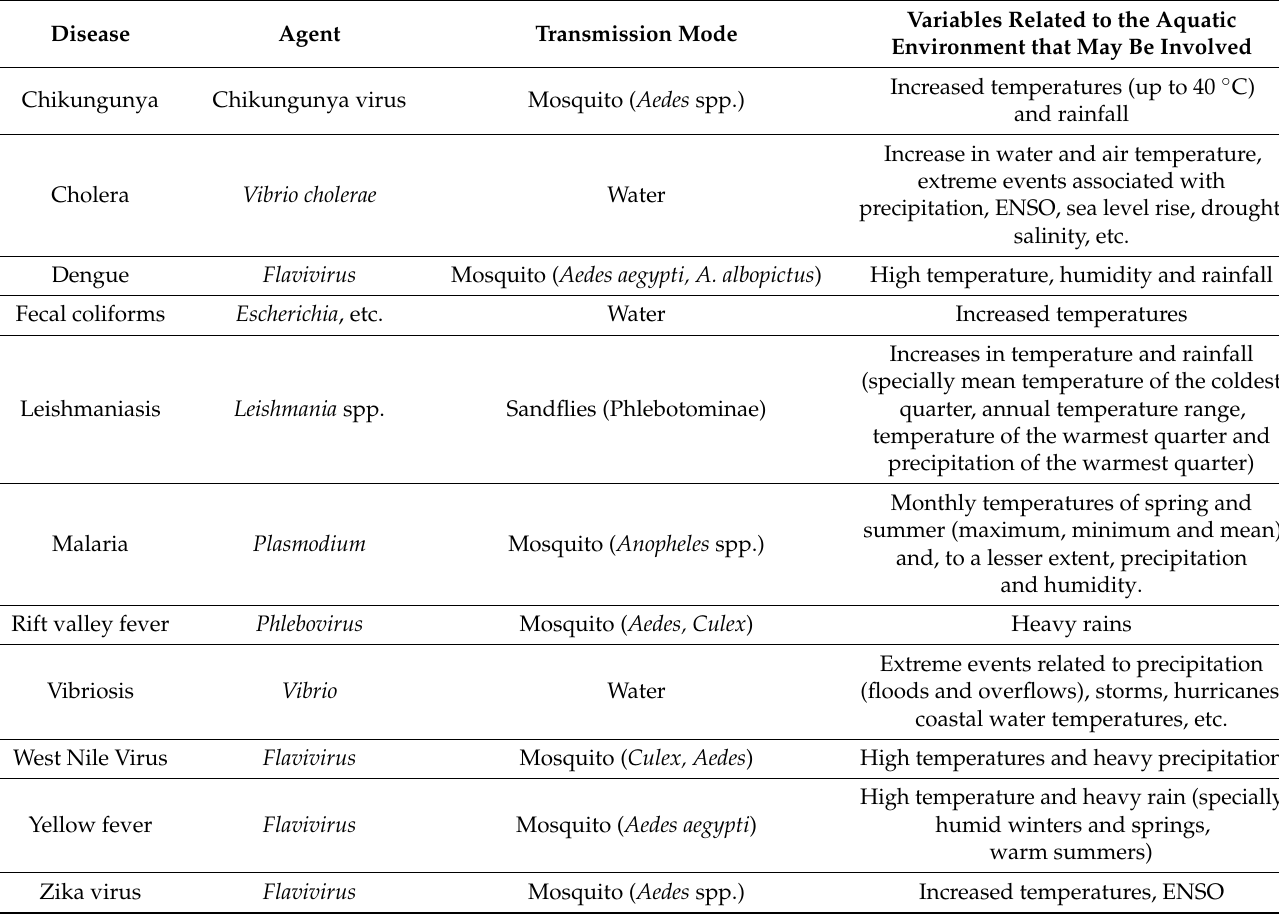
Table 1. Main infectious diseases related to aquatic ecosystems and variables related to climate change that may be involved.